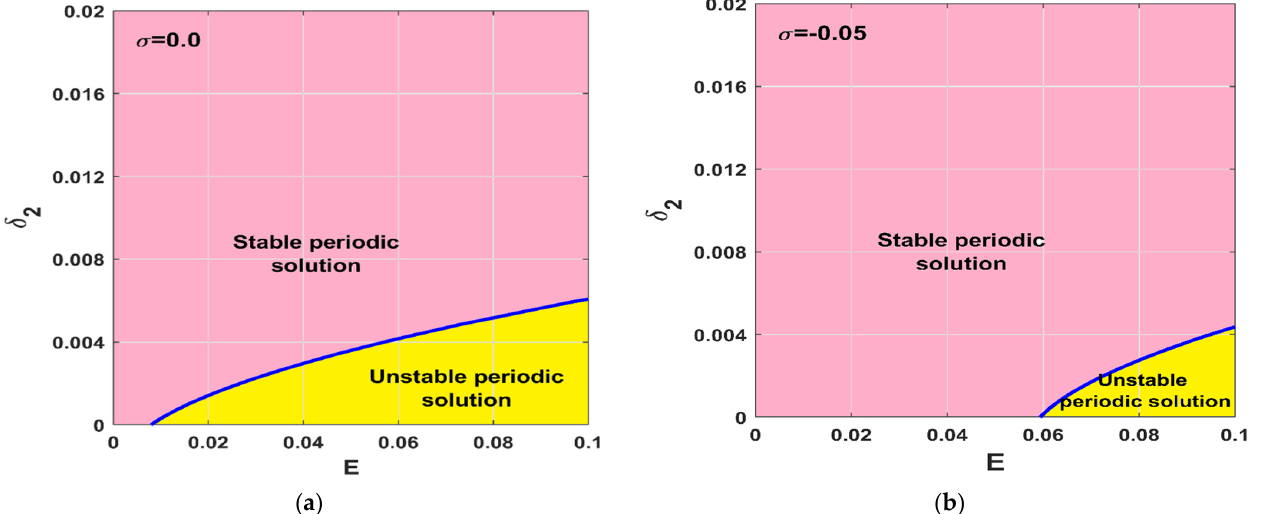
Figure 19. Stability charts of the controlled Jeffcott rotor in E − δ 2 plane when λ = 0.05, δ 1 = 0.83, and δ 2 = 0.002: ( a ) periodic and aperiodic solutions regions in E − δ 2 plane when σ = 0, ( b ) periodic and aperiodic solutions regions in E − δ 2 plane when σ = −